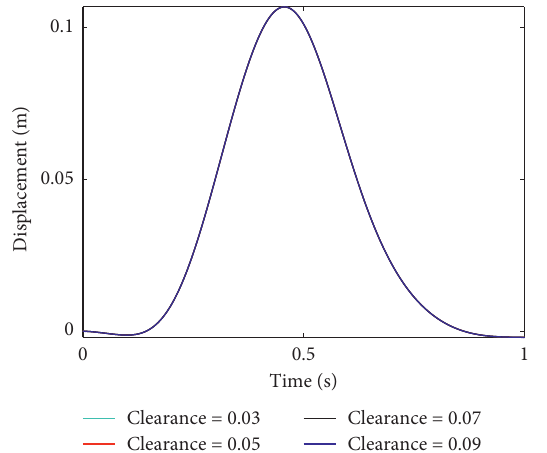
Figure 14: Displacement of the slider with different clearance values.